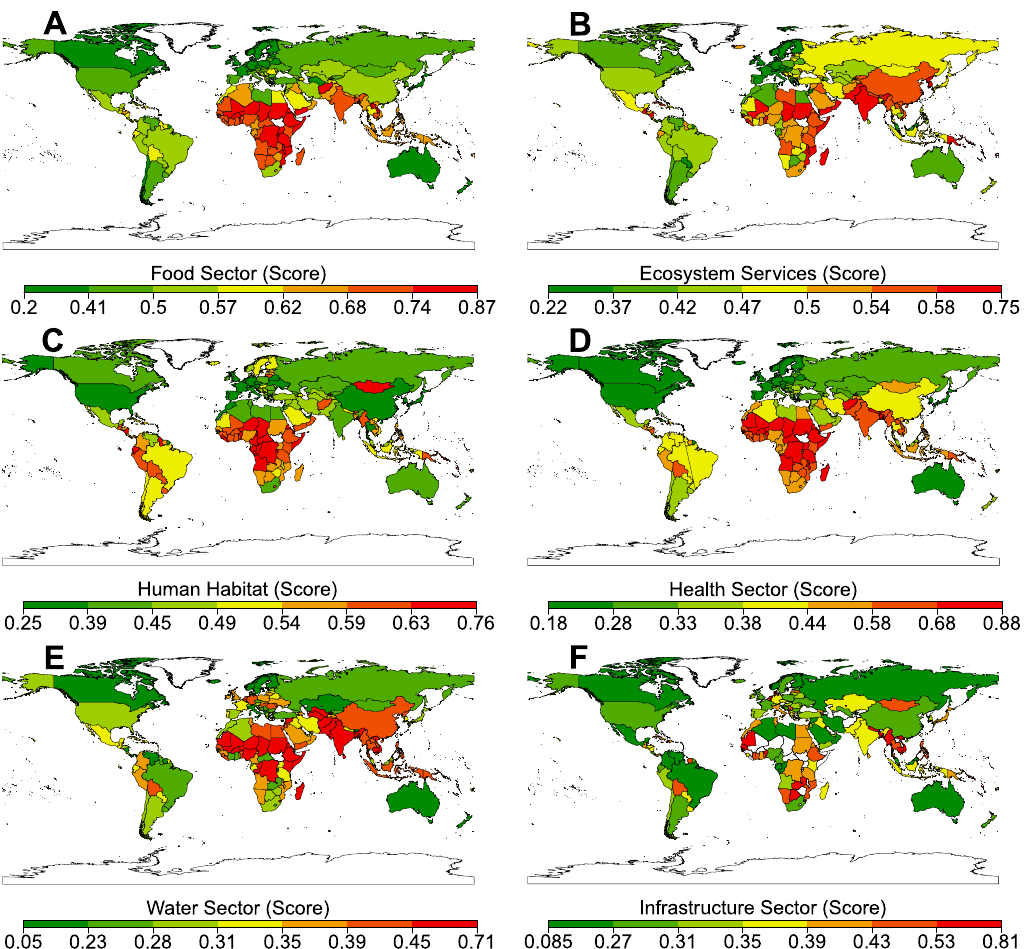
Fig. 3 Vulnerability of (A) Food Sector (B) Ecosystem Services (C) Human Habitat (D) Health Sector (E) Water Sector (F) Infrastructure Sector — to climate change and its impacts. From green to red denotes low to high vulnerability. The method of country-level data categorization was based on quantiles, used to capture continuous intervals with uniform distribution. A — mean: 0.57, min: 0.20, and max: 0.84 ( N = 188); measured in scores, dimensionless. B — mean: 0.47, min: 0.22, and max: 0.74, ( N = 181); measured in scores, dimensionless. C — mean: 0.50, min: 0.26, max: 0.75, ( N = 178); measured in scores, dimensionless. D — mean: 0.46, min: 0.18, max: 0.84 ( N = 188); measured in scores, dimensionless. E — mean: 0.33, min: 0.05, max: 0.69 ( N = 177); measured in scores, dimensionless. F — mean: 0.37, min: 0.08, max: 0.79 ( N = 1 52); measured in scores,